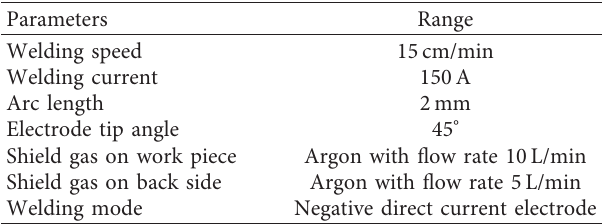
Figure 1: Experimental setup of TIG welding with flux paste (a motorized carriage, torch-workpiece). Table 2: Welding parameters.